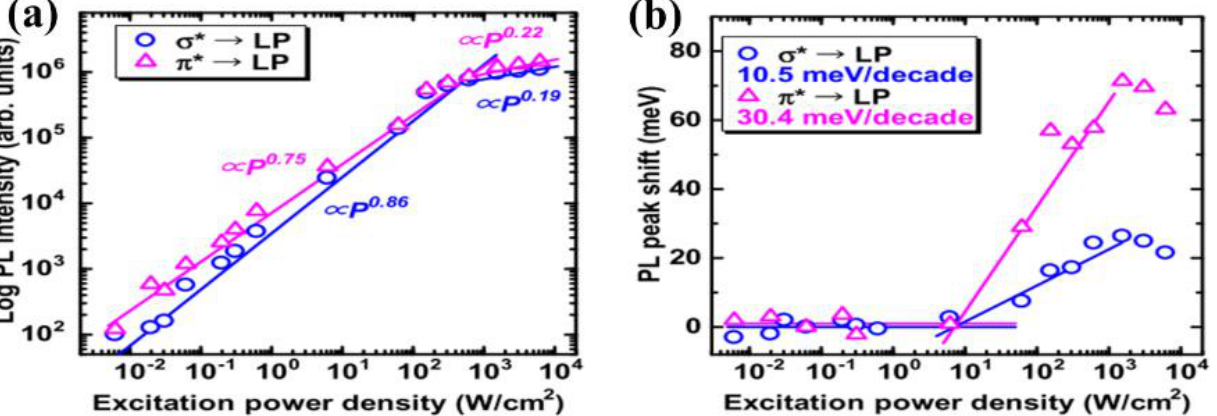
Figure 5. Excitation-power dependence of ( a ) the integrated PL intensities and ( b ) PL peak shift for σ* - LP and π* -LP transition paths of the thin film. Reprinted with permission from ref. [56] Copyright 2019 Japan Society of Applied Physics.